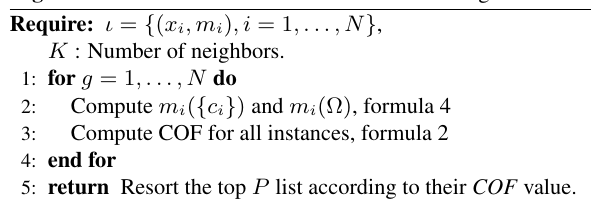
Algorithm 1 Pseudo-code of the modified CODB algorithm